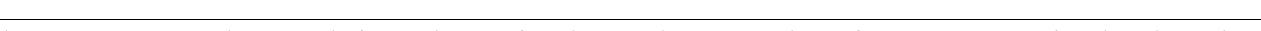
Fig. 4e, f) in the synchronized vs. desynchronized trials relative to